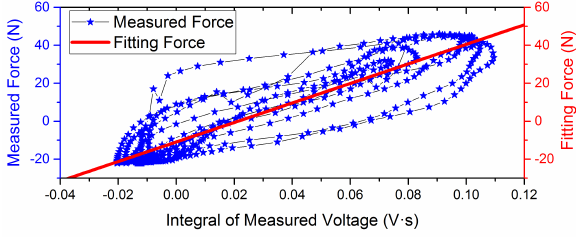
Figure 8. Fitting curves of the measured force and integral of voltage with drive current = 0